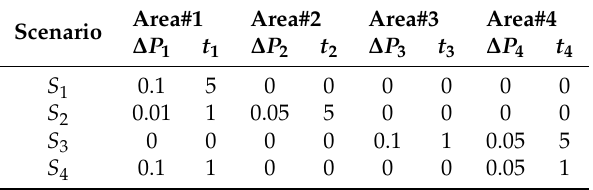
Table 2. The disturbances and their time considered in the simulation